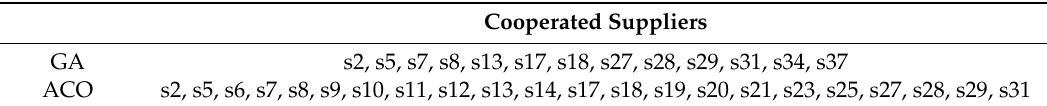
Table 7. Summary of